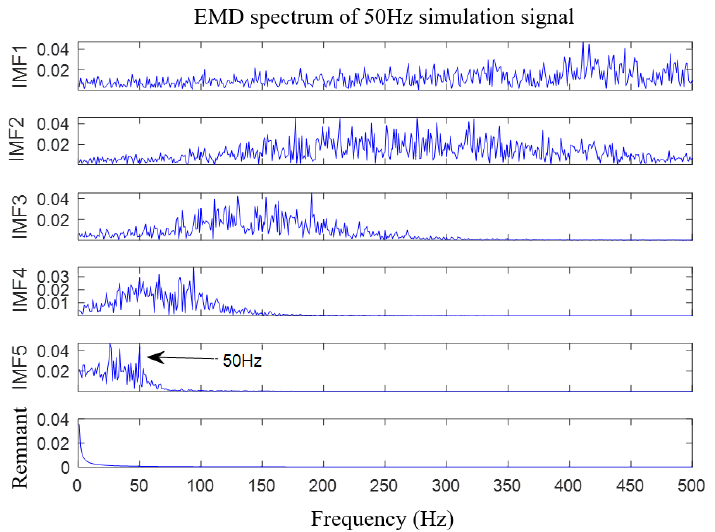
Figure 9. The processing results of the original noisy signals.